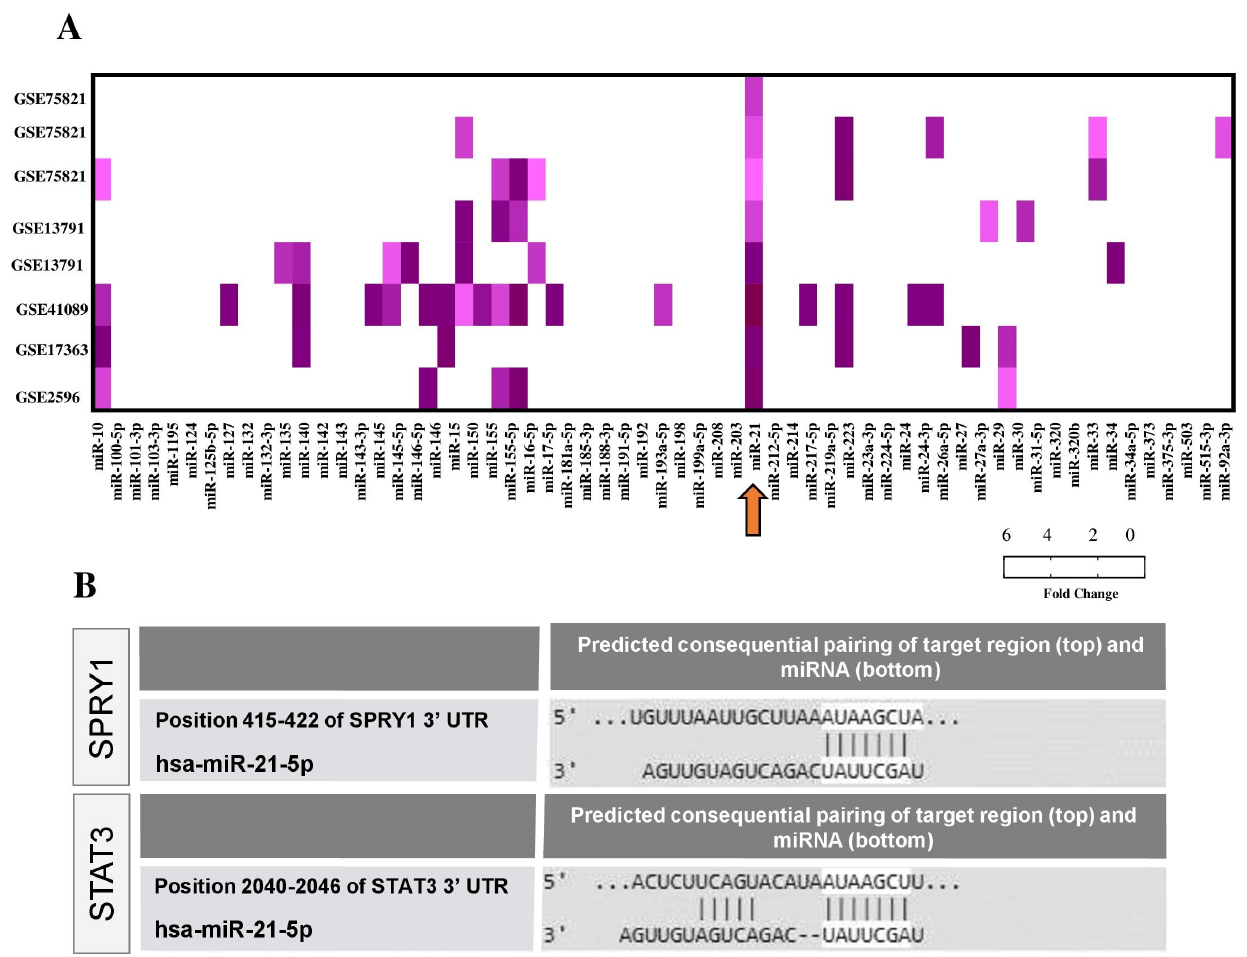
Figure 2. In silico analysis of miRNA-mRNA interactions in Chagas disease. ( A ) miRNA expression in GEO datasets related to Chagas disease presented as -Log10 ( p -value). Arrow indicates the miR-21 in all datasets. Datasets GSE75821 and GSE13791 referred to the results of in vitro studies that evaluated gene expression in host cells after T. cruzi infection. The dataset GSE41089 refers to a study that investigated cardiac mRNA expression during acute T. cruzi infection in C57BL/6. GSE17363 includes the results of mRNA expression in heart samples from C57BL/6 mice chronically infected with T. cruzi. GSE2596 shows mRNA expression profile in explanted hearts of patients with Chagas cardiomyopathy. The mRNA expression data and p -values were exported after being re-analyzed using the GEO2R. ( B ) Predicted consequential pairing of the target region (SPRY1 and STAT3) and conserved sites for miR-21-5p by TargetScanHuman.